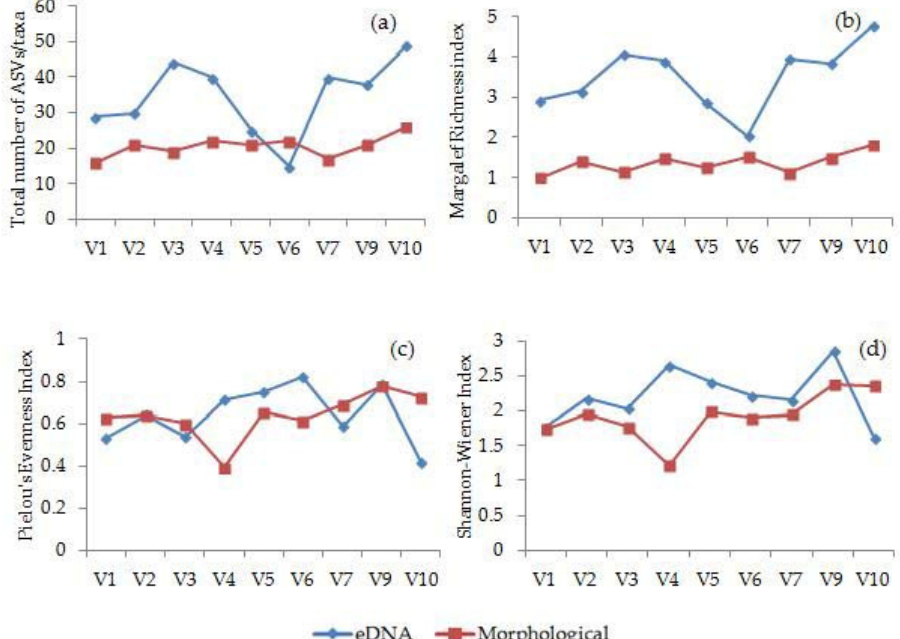
Figure 10. Phytoplankton diversity: ( a ) Total number of phytoplankton ASVs and taxa, ( b ) Margalef Richness Index ( d ), ( c ) Pielou’s Evenness Index ( J’ ), and ( d ) Shannon–Wiener Diversity Index ( H’ ) for eDNA (blue line) and morphological composite samples (red line) on sampling stations (V1 to V10, excluding station V8) in Lake Visovac during August 2018.